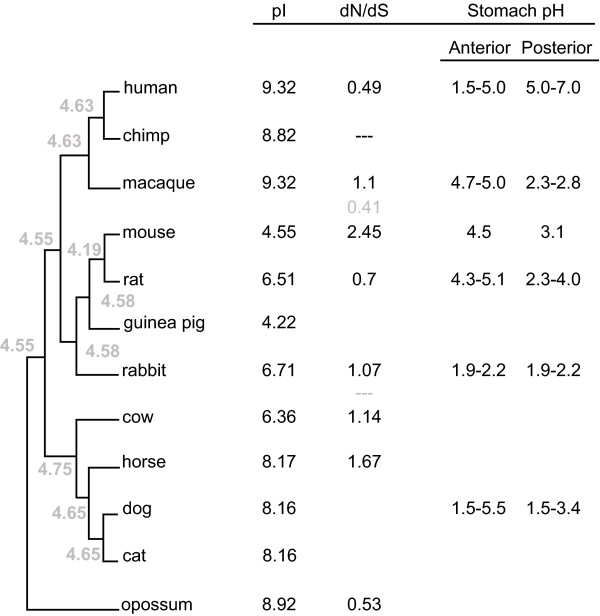
Ancestral reconstruction of κ-casein and the representation of pI, dN/dS ratio and the stomach pH values. Ancestral values are represented in grey. The ratio dN/dS was calculated only for species with a well-defined cDNA (this is not the case for guinea pig, cat, and dog). When the ratio dN/dS is undefined due to extremely small dS values we used the symbol "--". Despite the fact that the pH of other digestive compartments can show marked differences between mammals, we chose only to represent the stomach pH values, as this compartment is the main first barrier for milk proteins. A review of the pH values is reported in Table 5 of the following reference [24] (p366), we could not find well-defined values for chimp, horse, cow, and guinea pig.